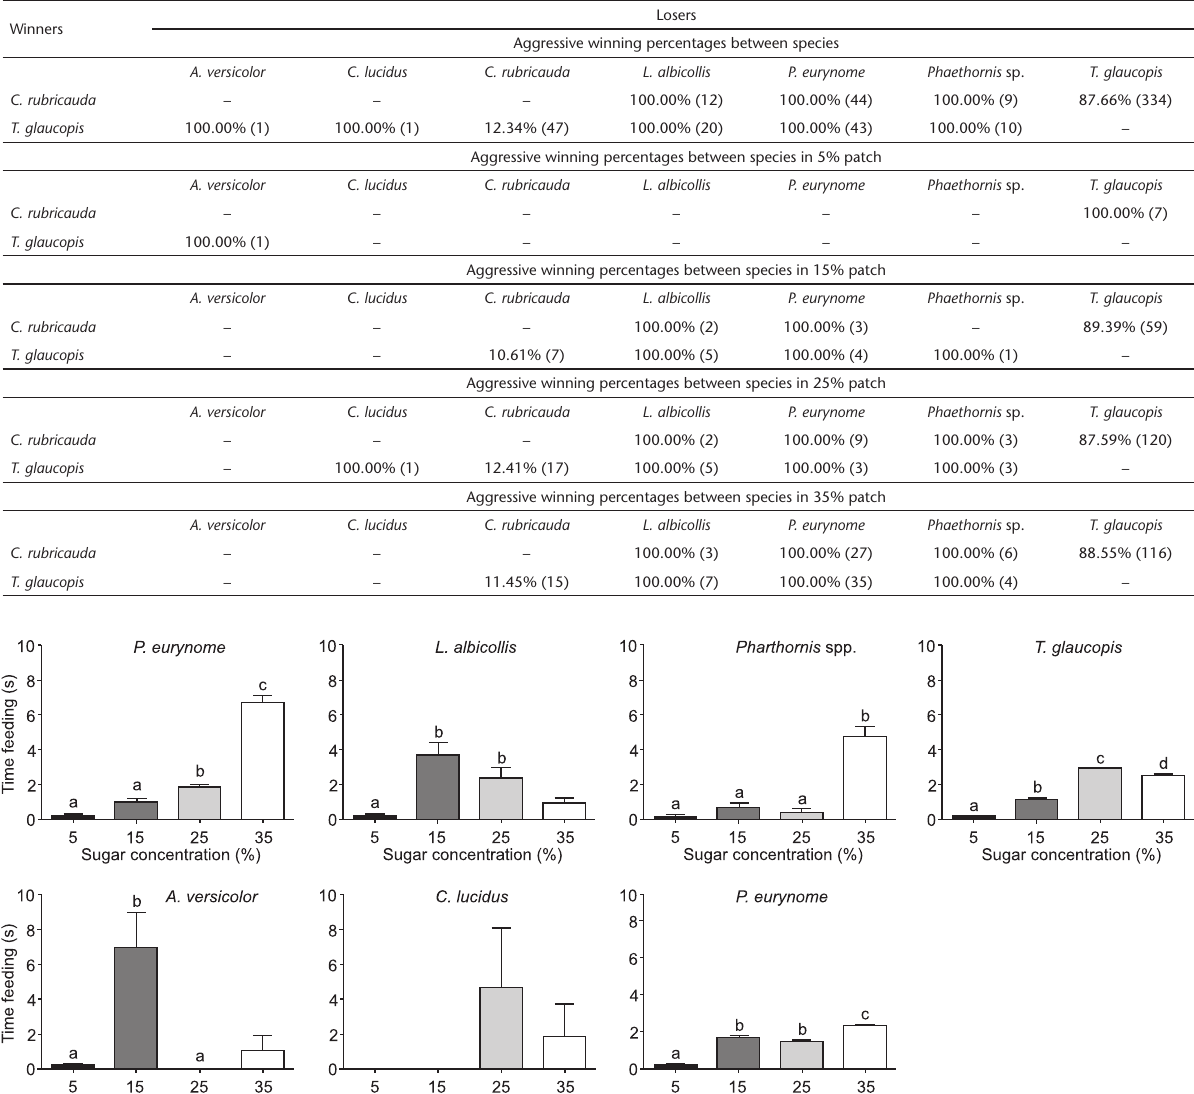
Table 3. The outcomes of aggressive encounters between different hummingbird species in relation to different sugar solution. Winners